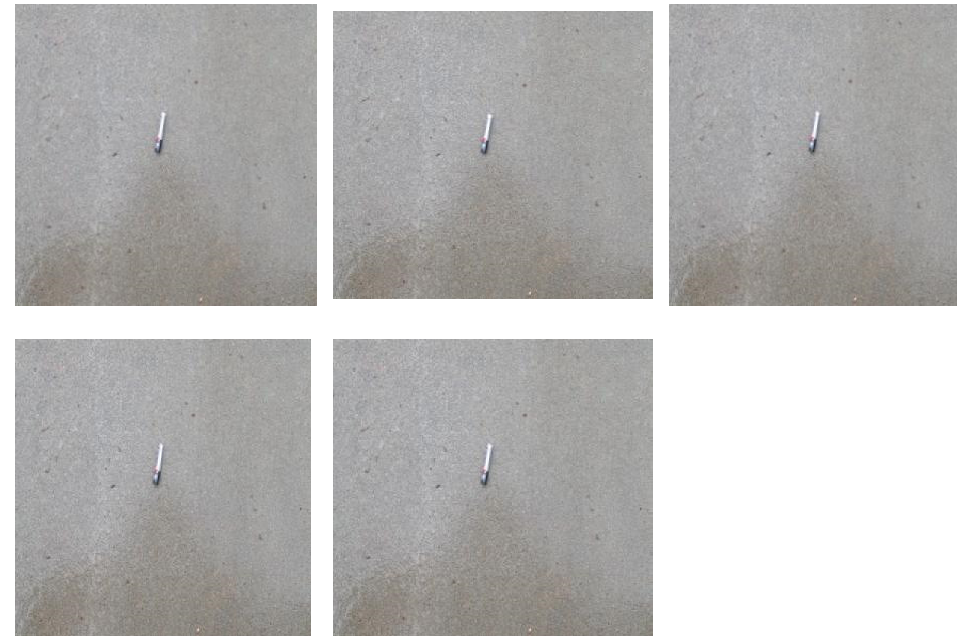
Figure 4. Sample dataset.